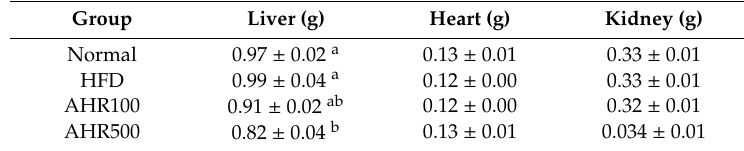
Table 5. E ff ect of AHR on tissue weight in HFD-induced Table 5. Effect of AHR on tissue weight in HFD-induced mice.